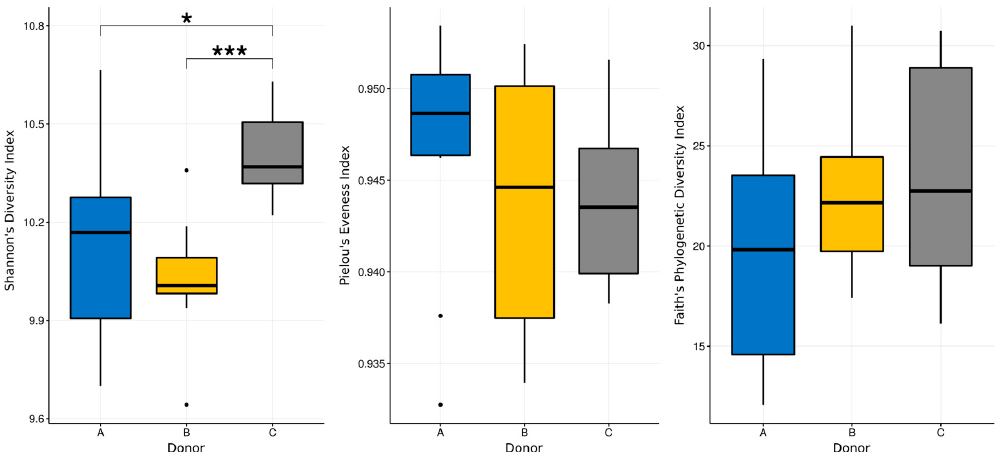
Figure 6. Boxplots showing selected biodiversity indices calculated for the data from the metabarcoding analysis. Kruskal ‐ Wallis test was used to detect statistically significant differences. * ‐ p ‐ value less than 0.01; *** ‐ p ‐ value less than 0.001.